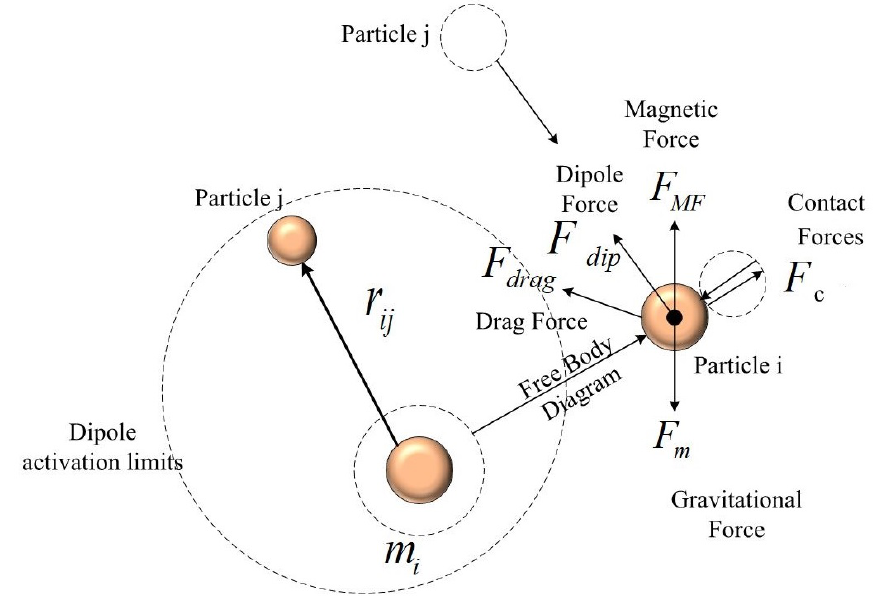
Figure 2. Free body diagram of the dominant forces